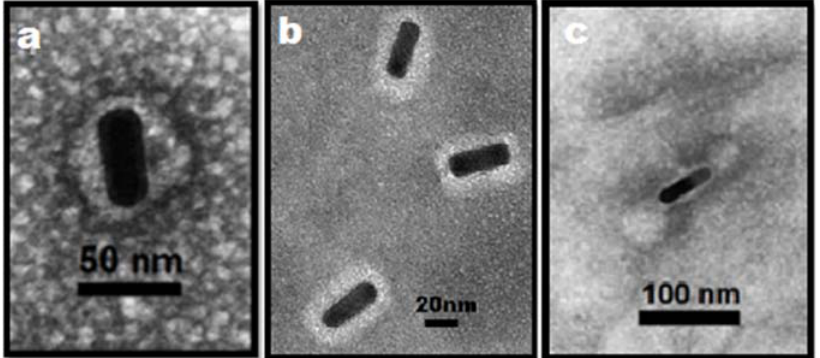
Figure 8. Negative stained TEM micrograph of gold nanorods encapsidated by the CP of CCMV, forming different enveloped structures. ( a ) Nanorods are contained in a single nonsymmetrical capsid. ( b ) The proteins form a nanotube capsid along the longer axis. ( c ) In addition to encapsidating the nanorod, the CP forms icosahedral structures on the tips of the nanorods.